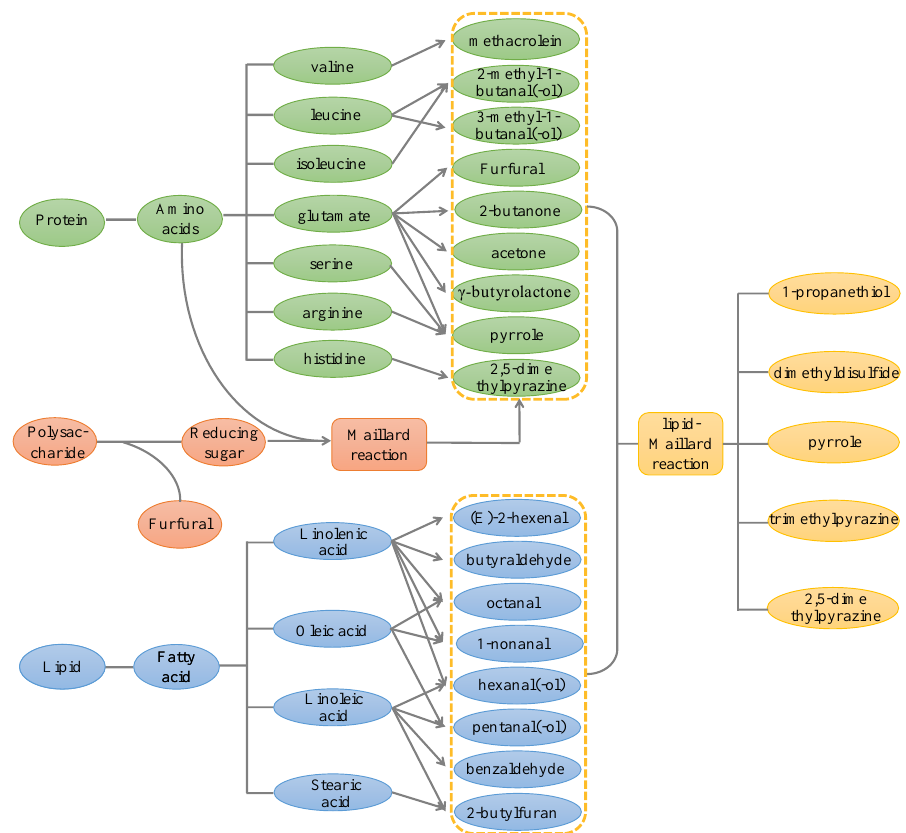
Figure 6. Mechanism of flavor formation in pomegranate seed processing.